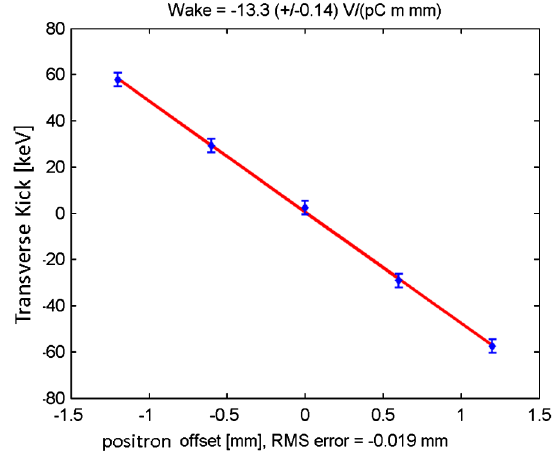
FIG. 5. Calculation of transverse wakefield.